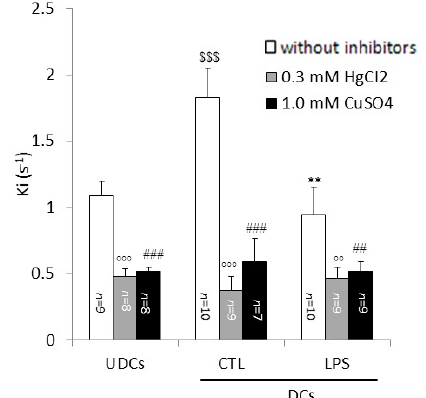
Figure 4. Relative contributions of AQP7 and AQP3 to glycerol permeability in plasma membrane vesicles from UDCs, CTL-DCs and LPS-DCs. Ki values were determined by stopped-flow light scattering analysis of plasma membrane vesicles prepared from UDCs, untreated DCs (CTL) and LPS-treated DCs (LPS) in the absence or presence of 0.3 mM HgCl 2 or 1.0 mM CuSO 4 as described in Materials and Methods. The results are the mean ± S.E.M. of the Ki values from 7 to 12 independent vesicles preparations. Data were analyzed using One-way ANOVA and Bonferroni post-hoc t -test. For HgCl 2 : °° p < 0.01 and °°° p < 0.001 vs. without inhibitors; for CuSO 4 : ## p < 0.01 and ### p < 0.001 vs. without inhibitors; $$$ p < 0.01 vs. UDCs without inhibitors; ** p < 0.01 vs. CTL without inhibitors.